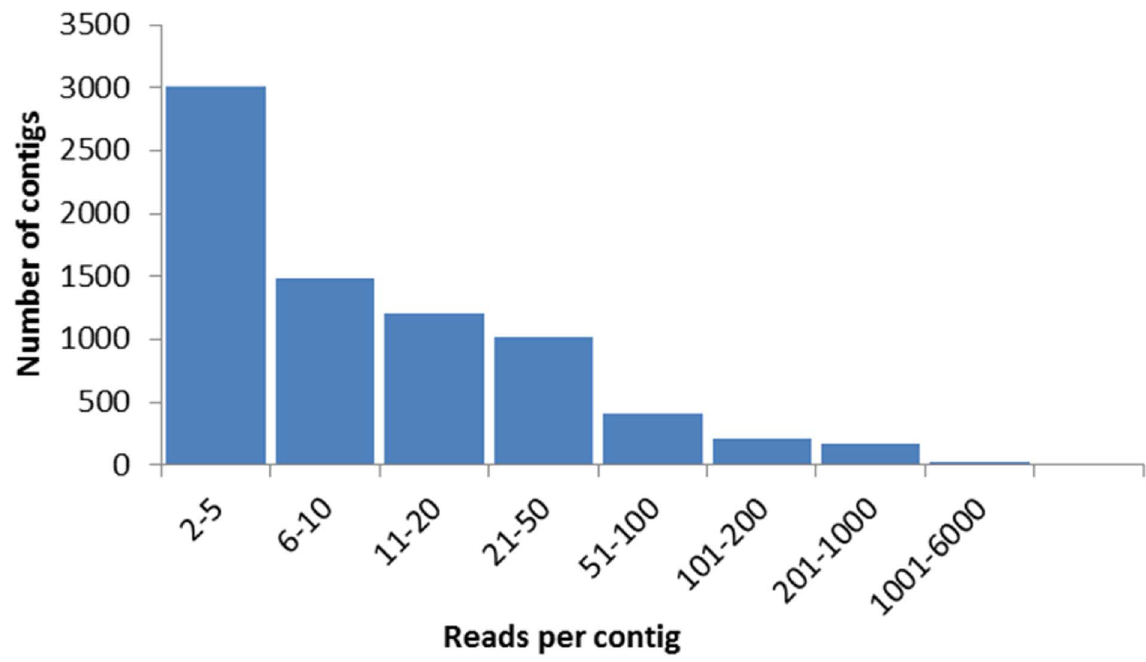
Figure 1. Number of sequences composing the assembled An.aquasalis contigs. A total of 7544 contigs were assembled from $ 2 sequences. The number of sequences that compose each contig varies from 2 to 5,207, with an average of 35 sequences per contig. Forty-three percent of the assembled contigs contained 10 or more sequences.